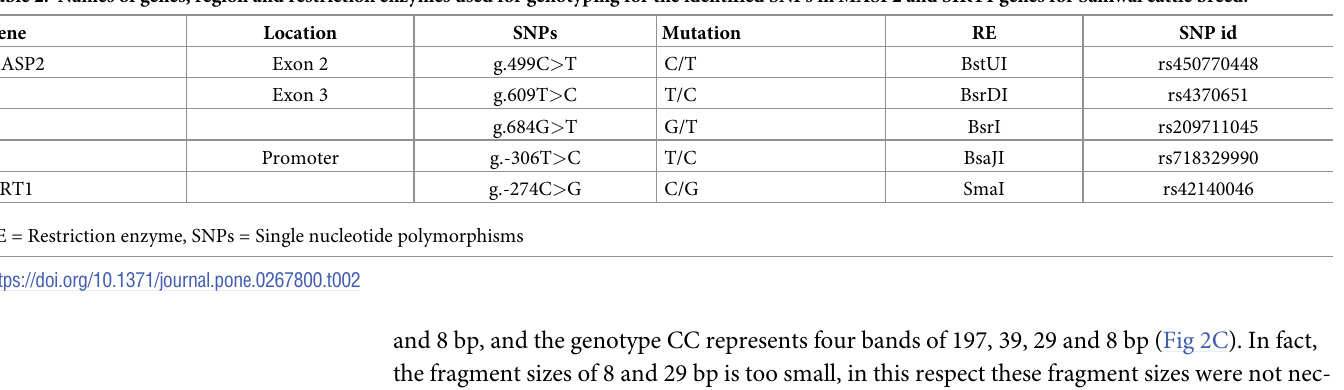
and 8 bp, and the genotype CC represents four bands of 197, 39, 29 and 8 bp (Fig 2C). In fact, the fragment sizes of 8 and 29 bp is too small, in this respect these fragment sizes were not nec- essarily observed in the gel. Moreover, SNP locus of g.-274C > G in the promoter region of SIRT1 gene was found in Sahiwal cattle with the enzyme SmaI, that revealed monomorphic patterns in all the studied population. These results differ from the previous findings [12, 13], where three genotypes in this SNP region (g.-274C > G) in Nanyang cattle breed of China and Agerolese cattle breed in Italy, respectively were reported. Interestingly, the polymorphism of these particular mutation site (g.499C > T, g.609T > C, g.684G > T and g.-306T > C) in SIRT1 gene in dairy cattle population is not reported so far. We acknowledge that, our study provides encouragement for a new way to reveal SNPs.